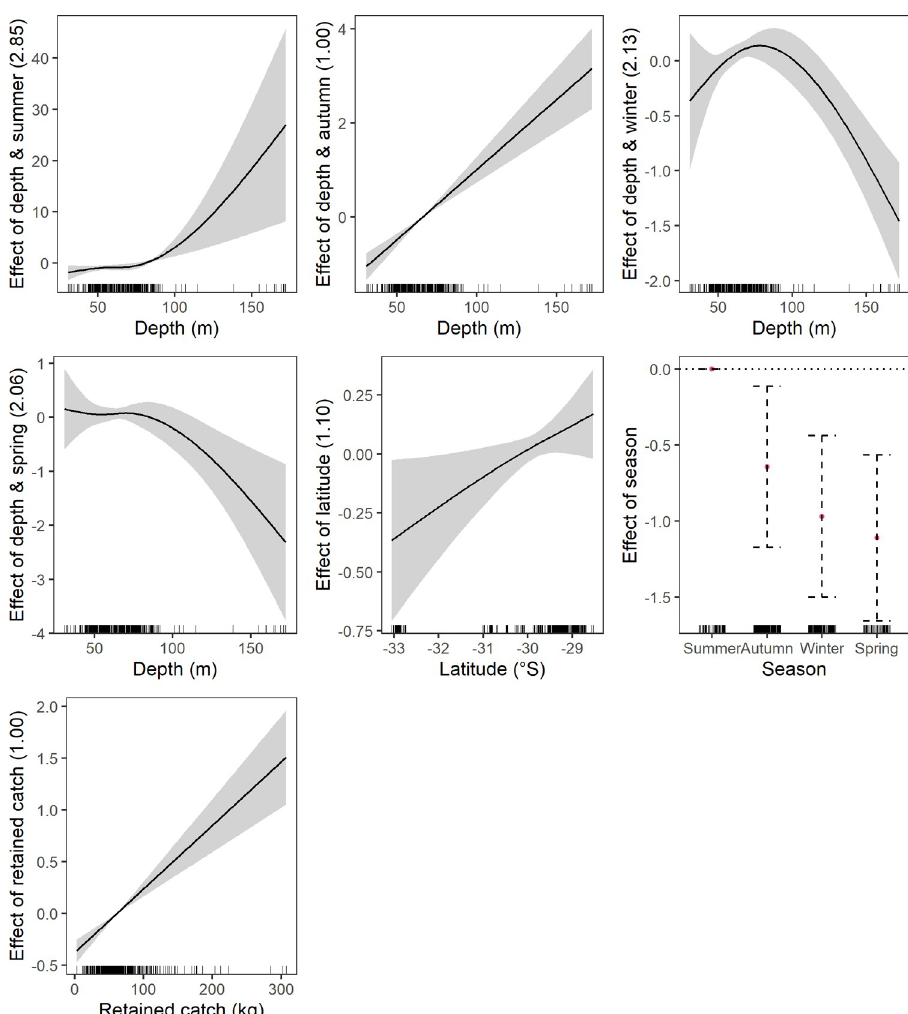
Fig 4. Significant effects plots from the discarded fish response generalised additive mixed models, shaded area represents the 95% confidence